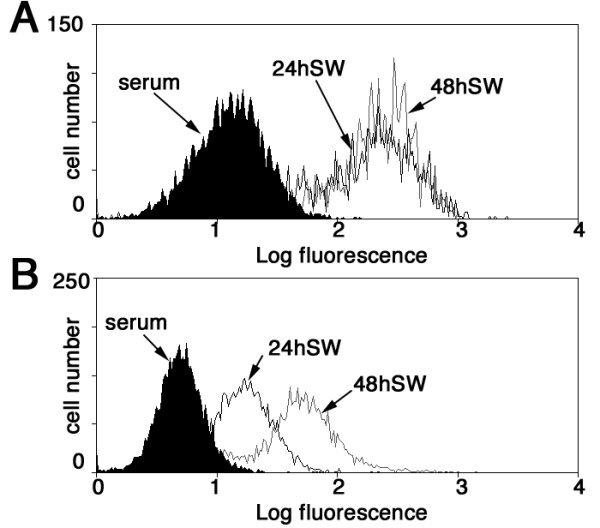
SM22 depletion reduces stress induced ROS production. ROS levels were measured in control REF52 cells (A) or SM22-depleted REF52-depleted cells (B) in normal serum conditions or following serum withdrawal for 24 or 48 h. In control REF52 cells both 24 h or 48 h serum withdrawal resulted in a 15-fold increase in ROS levels. REF52 cells depleted for SM22 (B) however, had 66% lower intrinsic ROS levels, and a considerably reduced ROS response to serum withdrawal for 24 h or 48 h (4-fold and 11-fold increase over untreated respectively). Control cell population is shaded in black, 24 and 48 serum withdrawal populations (24SW and 48SW) are indicated by black or grey lines respectively.